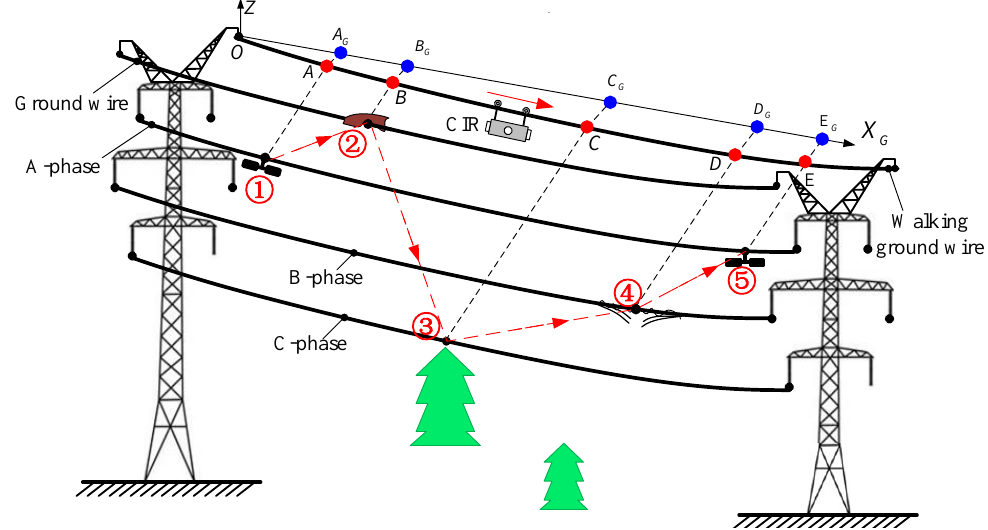
Figure 12. The schematic diagram of the generated inspection sequence.